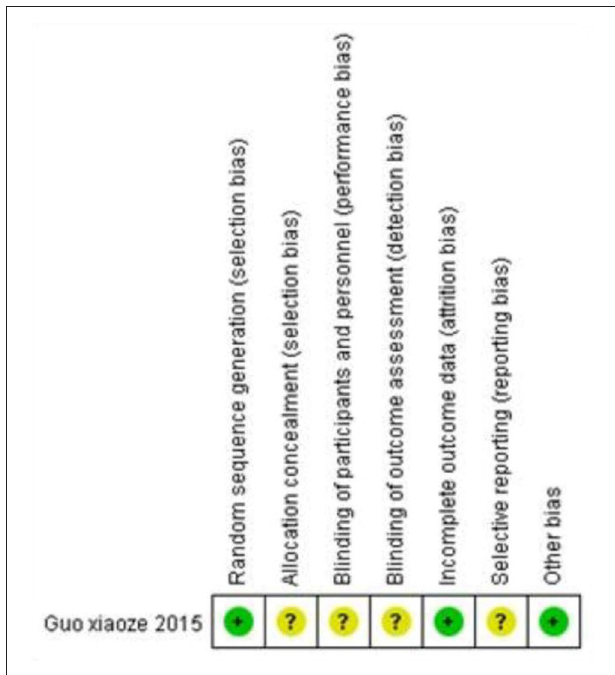
FIGURE 4 | Risk of bias assessment for the lone included randomized controlled trial.